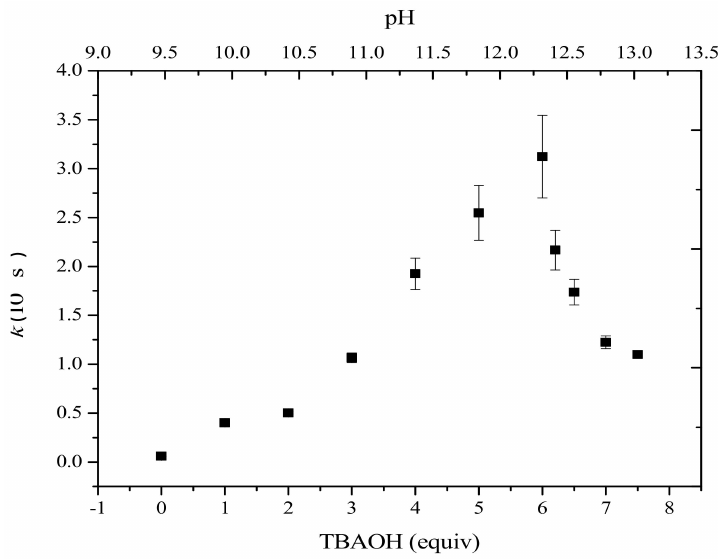
Figure 2. Variation of the pseudo first-order rate constant ( k , s − 1 ) of the formation of Cu(I) as estimated by fitting the measured electric current intensity at the polarized rotating electrode (+0.7 V/SCE) as a function of the initial concentration of TBAOH. For each point of the bell-shaped distribution, four experiments were repeated and the standard deviation was estimated (error